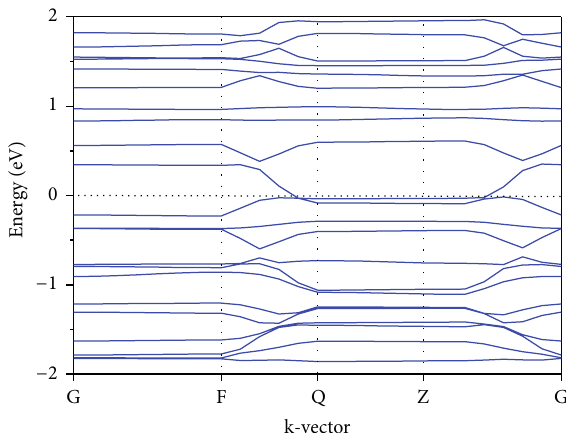
Figure 13: The electronic band structure of N2-doped single walled chiral (4,2) BNT. The Fermi level is set corresponding to zero energy and represented by dotted line.